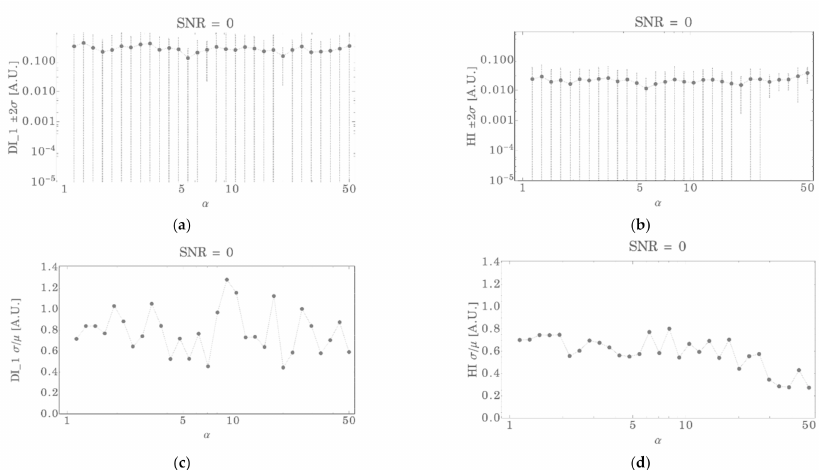
Figure 8. Mean value and standard deviation ( ± 2 σ ) of the estimators depending on the amount of damage α . ( a ) Double logarithmic scale representation of damage indicator DI 1 @ SNR = 0 dB; ( b ) double logarithmic scale representation of the proposed damage indicator HI @ SNR = 0 dB; (cid:16) (cid:17) σ ( c ) for DI 1 @ SNR = 0 dB; ( d ) µ